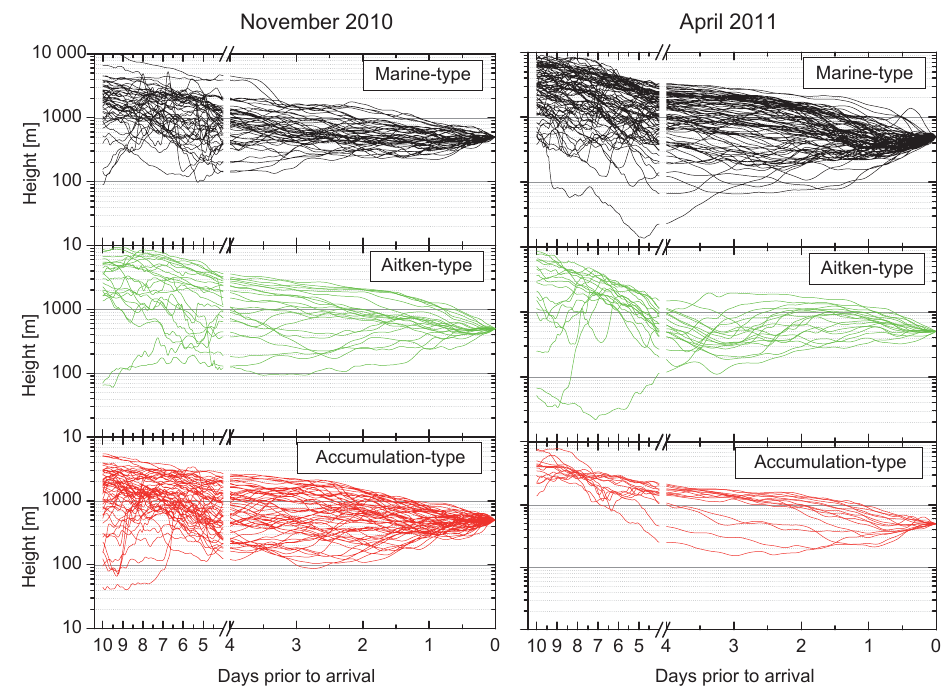
Figure 9. Heights of the 10-day back trajectories prior to arriving at Ragged